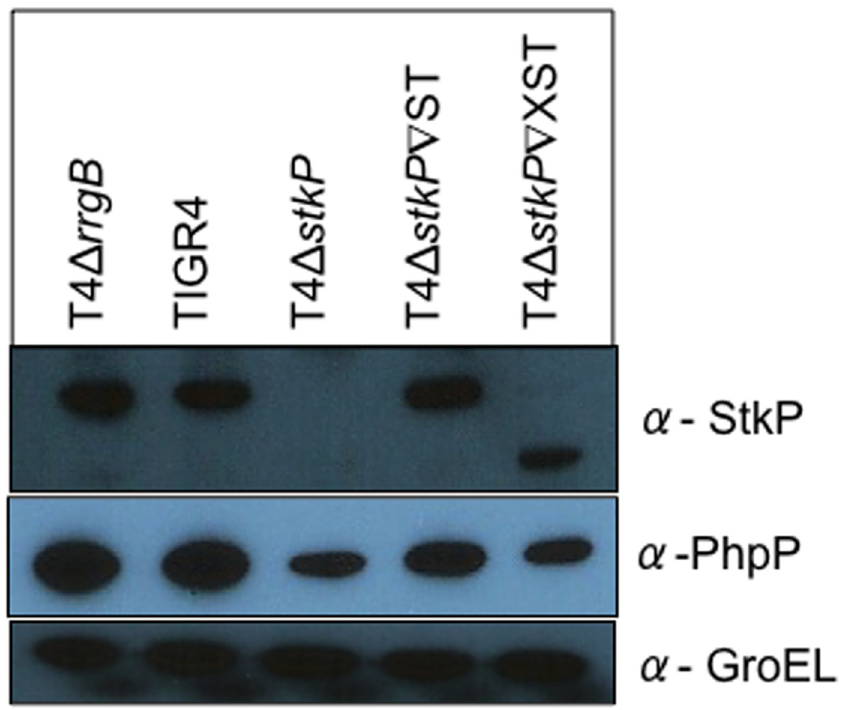
Fig 4. Stkp and PhpP protein expression in T4 Δ stkP and StkP complemented strains. Western blotting analysis was performed on TIGR4, T4 Δ stkP , T4 Δ stkP r ST, T4 Δ stkP r XST and T4 Δ rrgB at OD 0.6 (OD 600nm ) looking at expression of StkP and PhpP in all strains ( α -StkP/ -PhpP antibody). Equal protein loading was confirmed by equal expression of GroEL ( α -GroEL